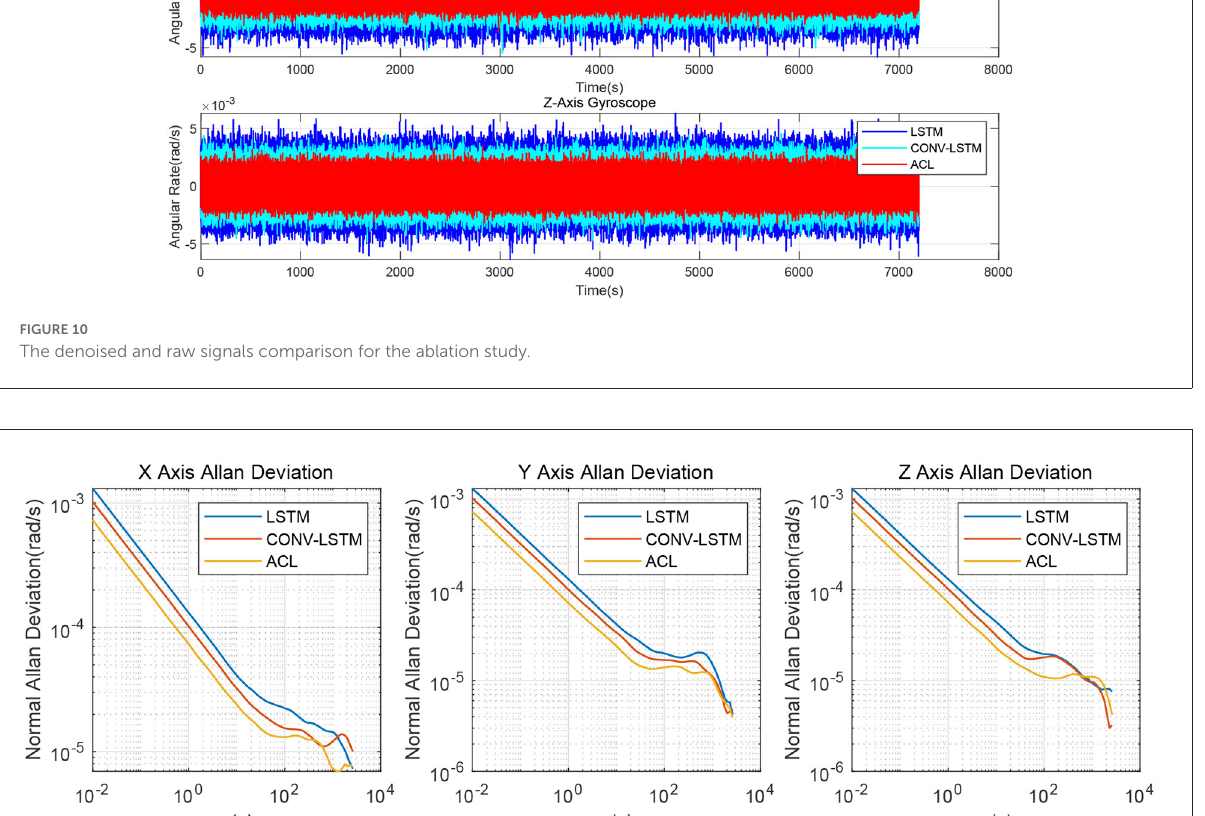
performance comparison between the LSTM, CONV-LSTM, and ACL